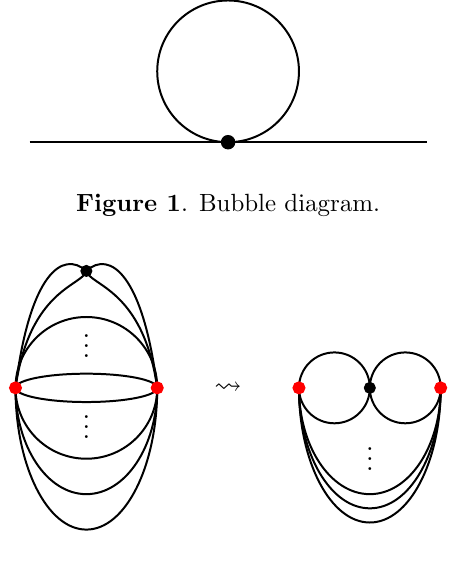
Figure 2 . The relevant one-loop diagram and its Kermit the frog